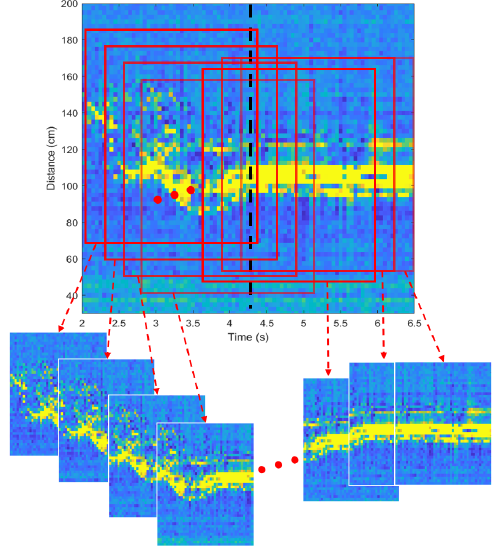
Figure 6. Generating cropped spectrograms.